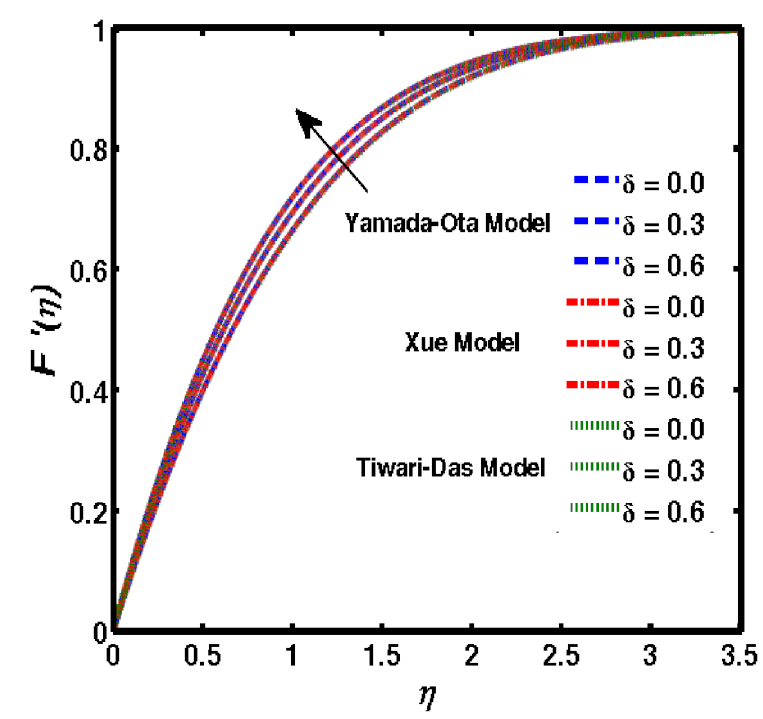
Figure 6. Influence of δ on F (cid:48) ( η ) .